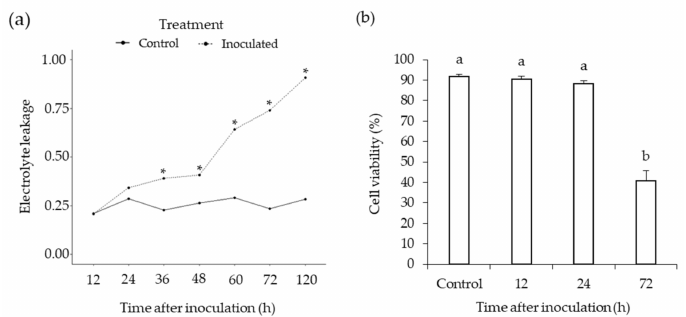
Figure 2. Phytophthora medicaginis displays a short biotrophic phase up to 24 h post-inoculation (hpi) before switching to a necrotrophic phase. ( a ) P. medicaginis induces significant root cell death from 36 hpi onwards. The x-axis shows the timepoints post-inoculation in hours (h) and the y-axis shows the arcsine-transformed electrolyte leakage proportions of pre-boiled relative to post-boiled root samples. * = significant differences in arcsine-transformed electrolyte leakage proportions between the inoculated and mock-inoculated control roots at a specific timepoints ( p < 0.001, LSD = 0.08). ( b ) P. medicaginis causes significantly lower root cell viability at 72 hpi. The x-axis shows the control and timepoints post-inoculation in hours (h), and the y-axis shows the ratio of living to dead cells. Lower-case letters indicate significant difference between treatments (ANOVA, p < 0.05; n = 6).